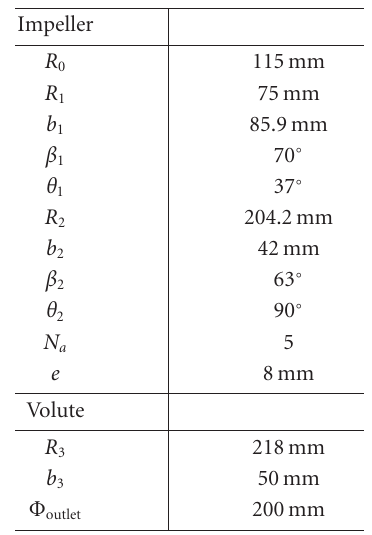
Table 1: Geometrical characteristic values.